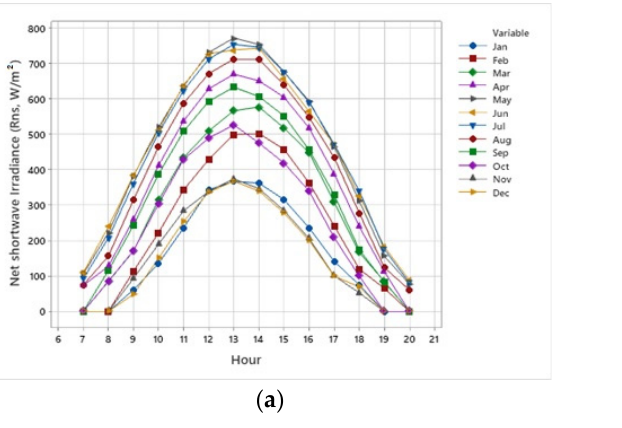
Figure 19. ( a ) diurnal variation of the average hourly values of R ns for each month of the year; and ( b ) monthly variability of net shortwave irradiances (W/m 2 ). Symbol * indicates an outlier.